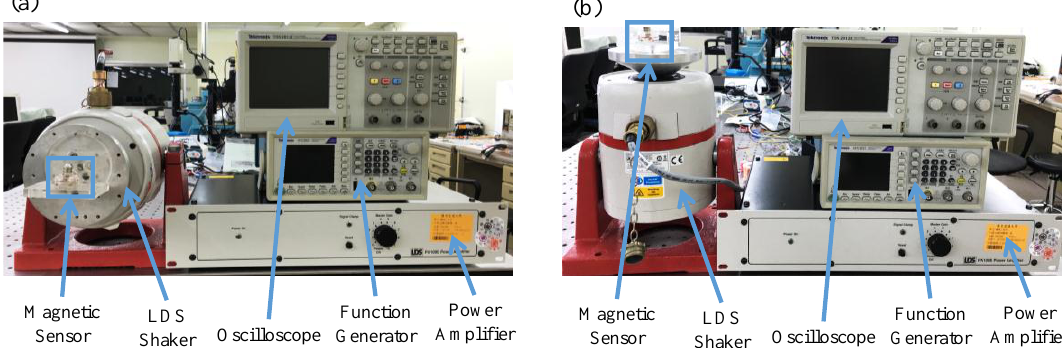
Figure 4. Testing setup of the piezoelectric/vibrational energy-harvesting functions of the sensor under ( a ) x -axis vibration and ( b ) z -axis vibration.